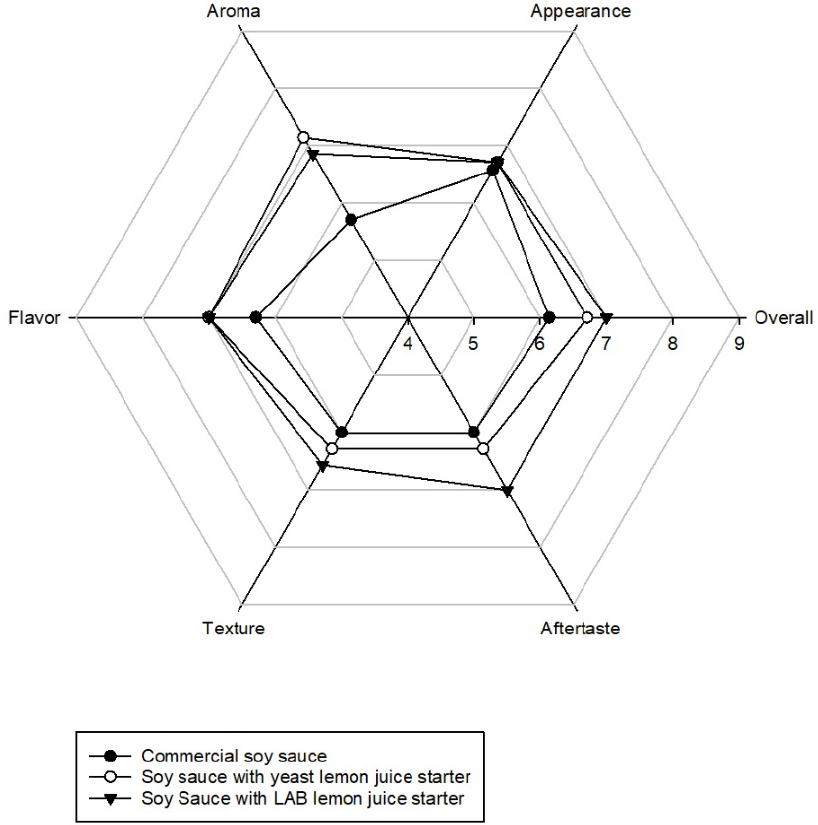
Figure 7. The sensory evaluation of soy sauces.